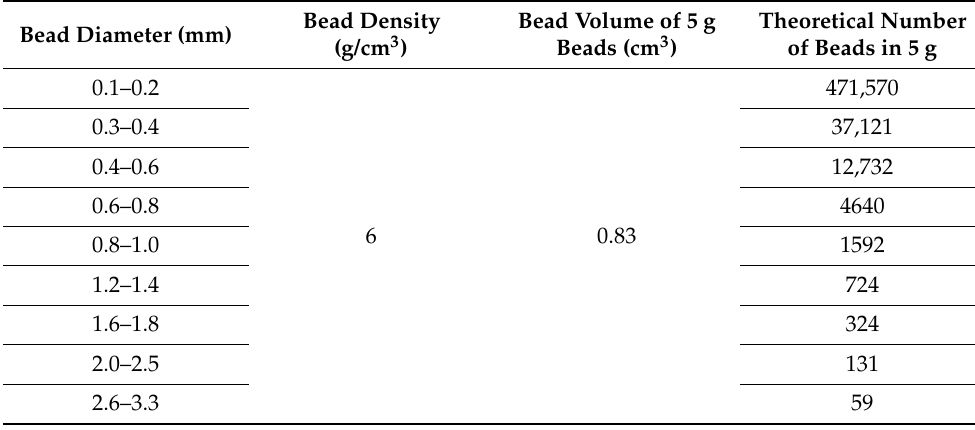
Figure 2. Effect of milling bead size on the ITZ particle size. Values are expressed as mean ± SD, n = 3. Milling was carried out at 4 ◦ C with 1500 rpm. * Bead size was 0.1–0.2 mm; stabilizer concentration had to be changed to 0.9% ( w / w ) HPC-SL, 0.28% ( w / w ) PS80 and 0.28% ( w / w ) SDS (see Section 4). Table 4. Overview of the bead diameters, density, bead volume and the number of beads used per